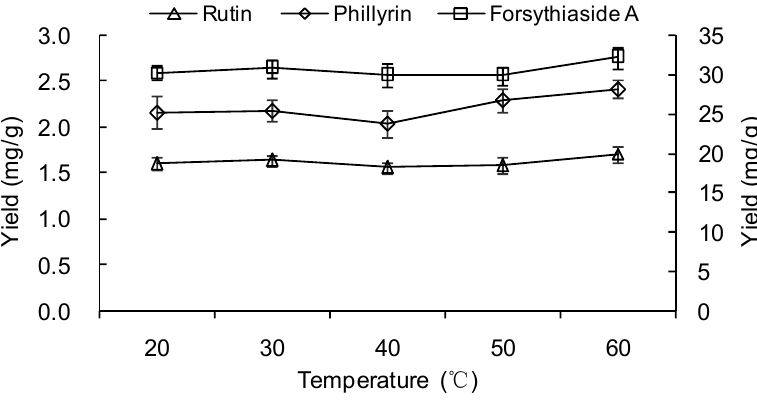
Figure 5. Effect of temperature on the extraction yields of forsythiaside A, phillyrin and rutin. The value of forsythiaside A is shown on the secondary y -axis on the right.